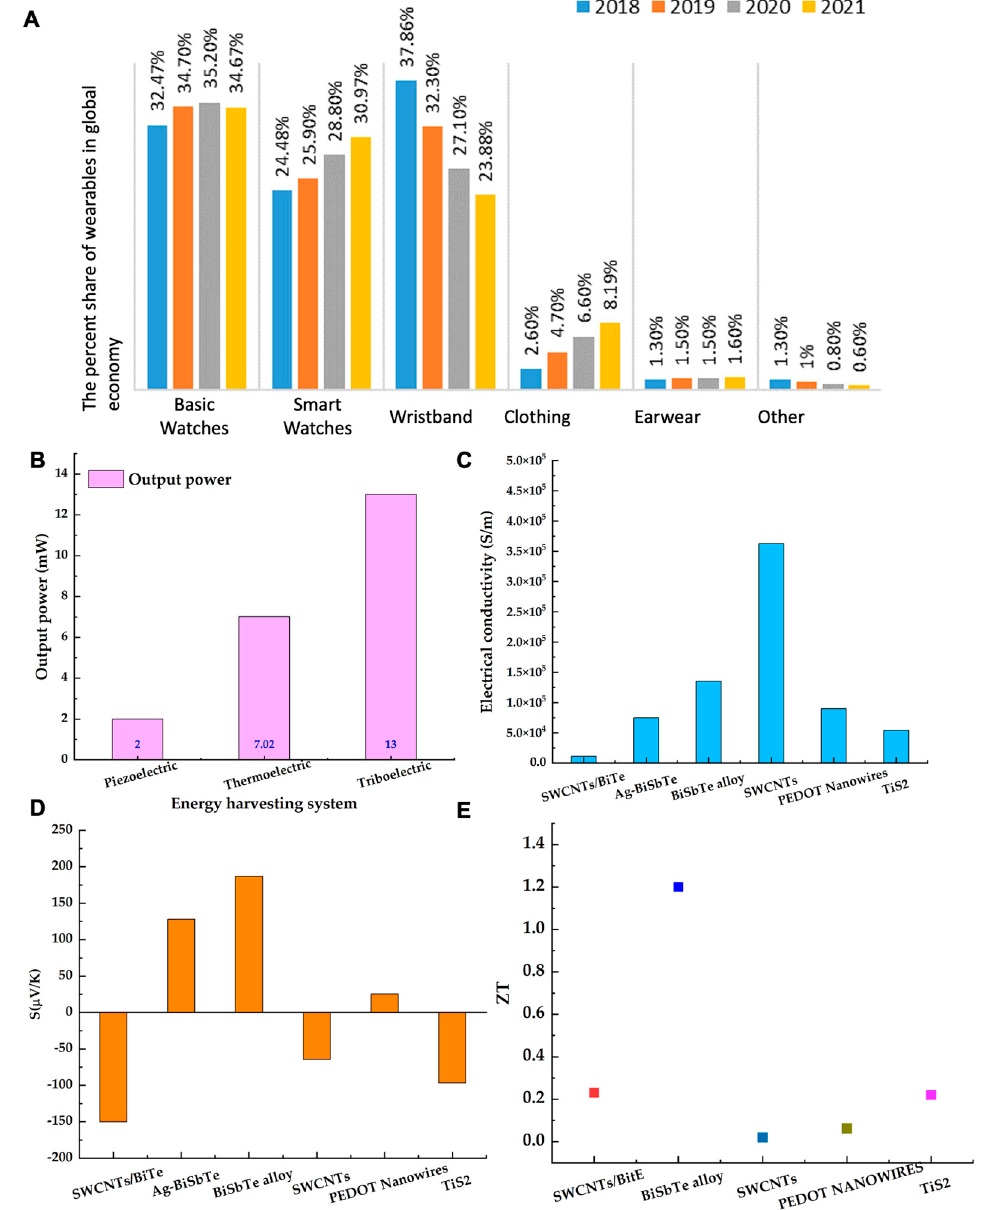
Figure 1. ( A ) The market share of wearable electronics in the global market between 2018 and 2021; reprinted from Ref. [2]. Copyright year (2020), Nozariasbmarz, A.; Collins, H.; Dsouza, K.; Polash, M.H.; Hosseini, M.; Hyland, M.; Liu, J.; Malhotra, A.; Ortiz, F.M.; Mohaddes, F.; et al. with permission from Elsevier; ( B ) The comparative analysis of the maximum reported output power generated by piezoelectric, thermoelectric, and triboelectric [9,10,21]. ( C – E ) The comparative analysis of electrical conductivities, Seebeck coefficient, and ZT of organic, inorganic, hybrid matrix, and polymer at room temperature for WTEG application, respectively [18–20,22,23]. (The ZT value of Ag-BiSbTe was not given, and it cannot be calculated because thermal conductivity of film was not reported in the article—[23]).